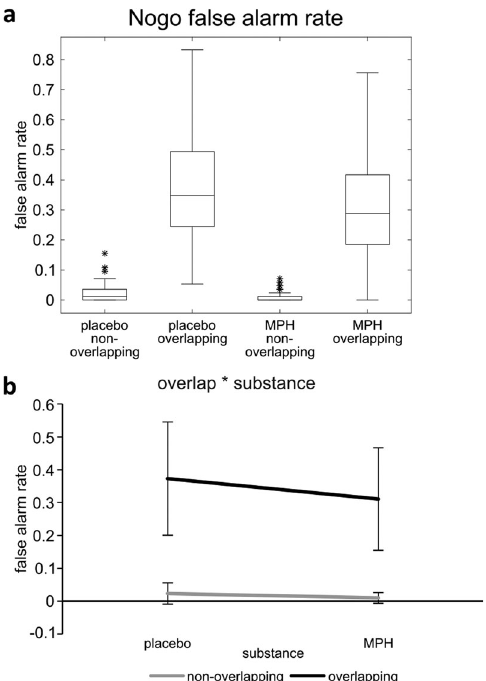
Fig. 1 False alarm rates of the non-overlapping and overlapping Nogo conditions in the placebo and MPH session. a Boxplots of the distribution of the false alarm rates of the non-overlapping and overlapping Nogo conditions in the placebo and MPH session of N = 78 participants. The sample median is shown as the line inside the box, the lower and upper quartiles are shown as the bottom and top edges of the box, the ends of the whiskers denote the non-outlier minimum and maximum, respectively, asterisks denote outliers. b Illustration of the signi fi cant interaction of the factors Overlap and Substance (same data as fi gure part a ). Error bars represent standard Fig. 1a, an illustration of the interaction of Overlap * Substance can be seen in Fig. 1b. The proportion of Nogo trials with an erro- neously given response in a particular condition out of all Nogo trials in that condition constituted the Nogo false alarm rate. A mixed-effects ANOVA with the within-subject factors Overlap (non-overlapping vs. overlapping condition) and Sub- stance (placebo vs. MPH session) and the between-subjects factor Group (Placebo- fi rst vs. MPH- fi rst) was conducted. The analysis revealed main effects of the factors Substance (F(1,76) = 38.70,